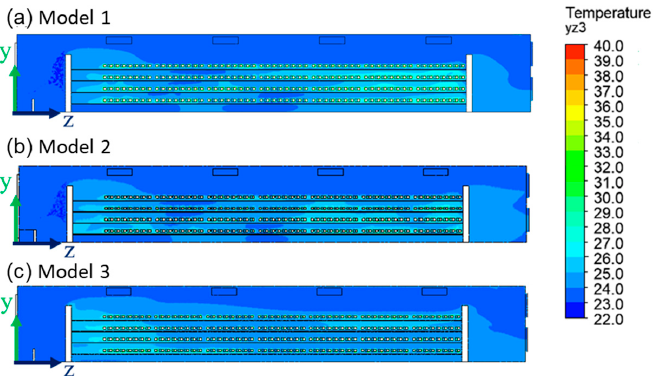
Figure 11. Temperature distribution of the three models’ yz plane of x = 2.6 m, at V = 6 m/s, ( a ) Model 1; ( b ) Model 2; ( c ) Model 3. Table 4. Temperature in cages.